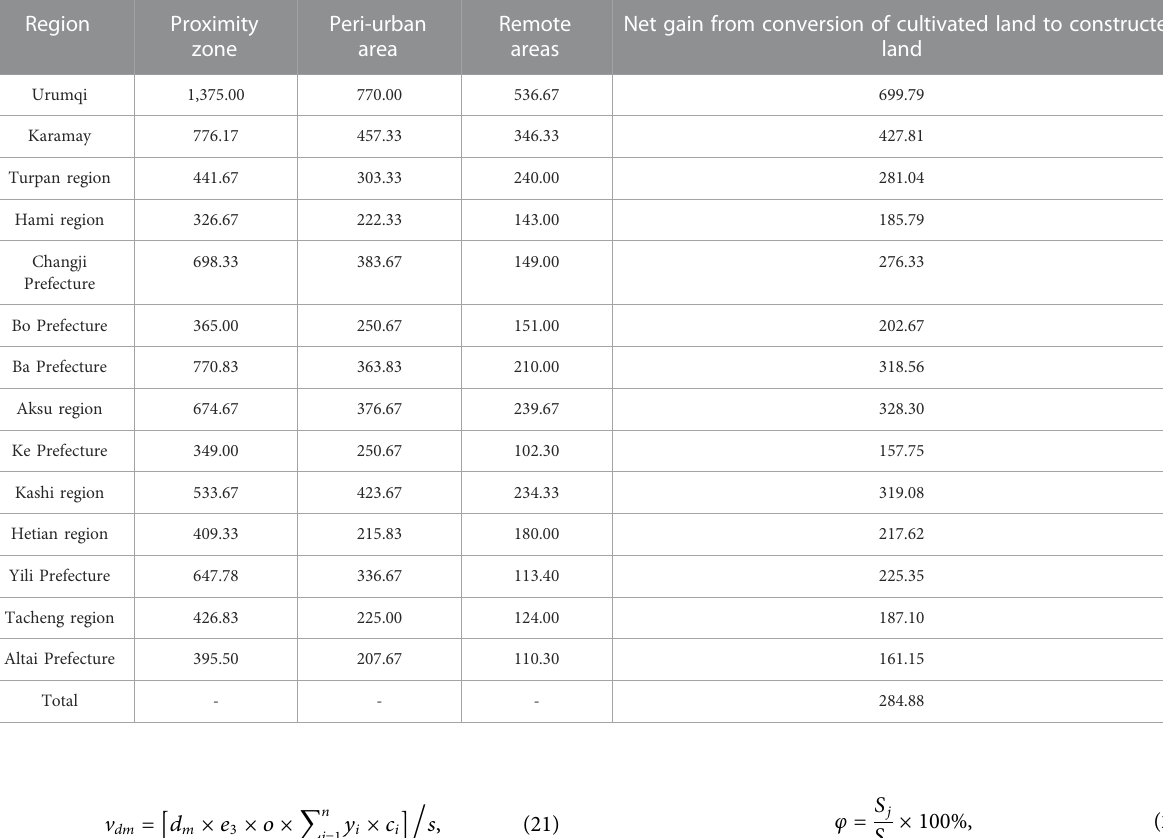
TABLE 2 Value of the cultivated land converted to construction land in the state (city) (10 4 RMB/hm 2 ).